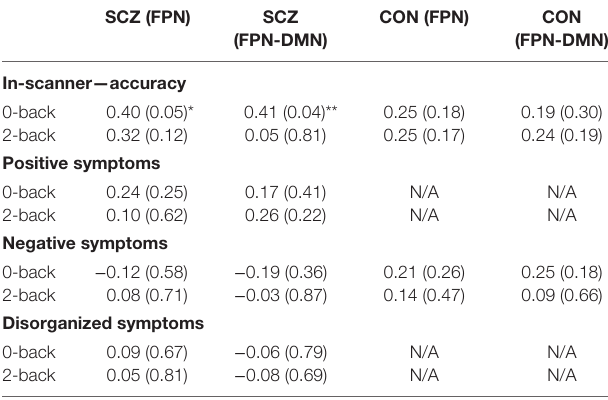
TaBle 3 | Clinical and cognitive relationships with frontoparietal network